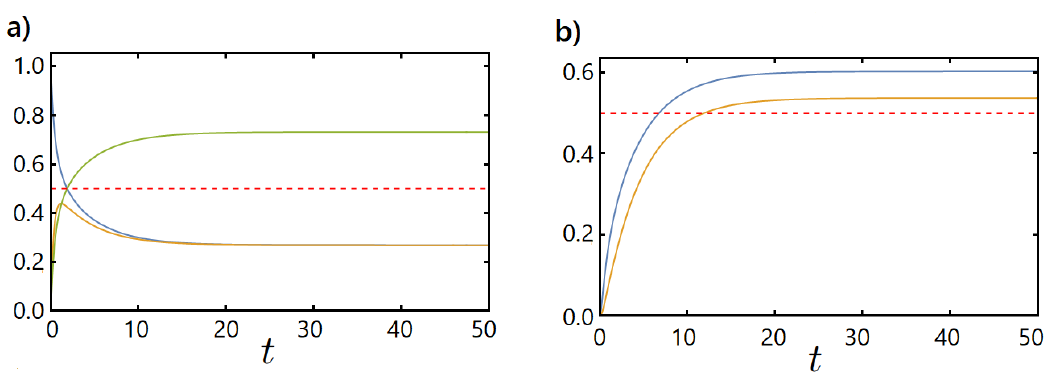
Figure 2: Panel a) incoming flow at line 1 (blue curve), outgoing flow at line 1 (yellow curve), occupancy on dot 1 (green curve) and Panel b) 〈 n 〉 (yellow curve) for Γ (cid:96) n n and 〈 n 1 2 3